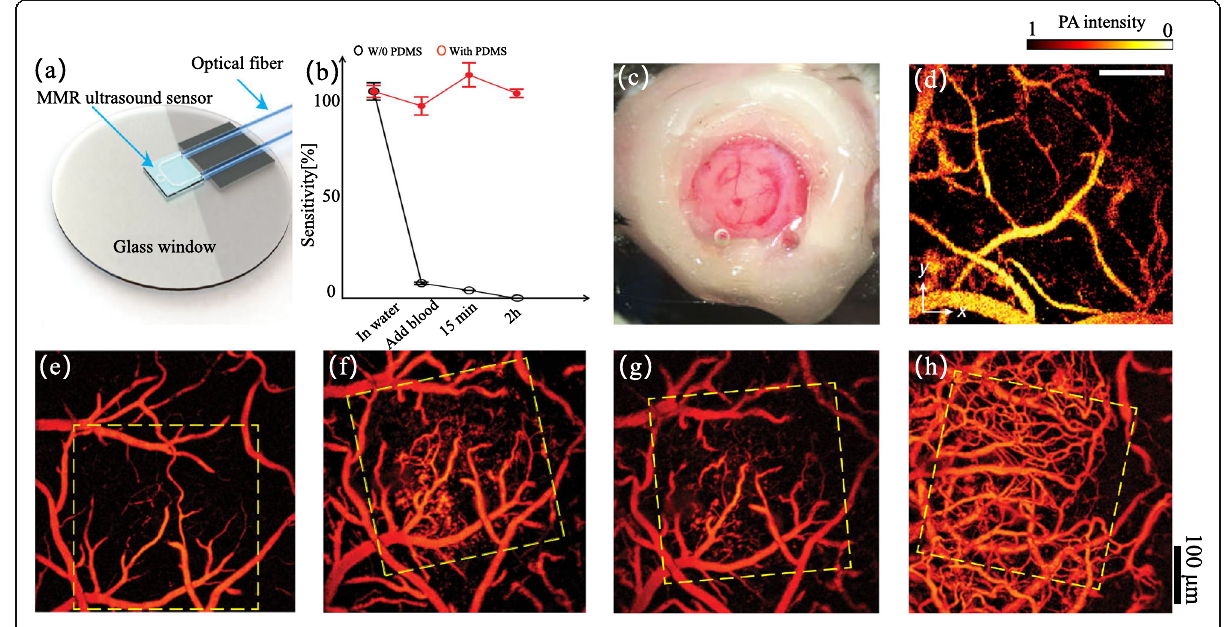
Fig. 5 a A schematic diagram of the ultrasound-sensing cranial window implant [42]. b Comparison of MRR Q-factors with and without the protection layer in whole blood. c A photograph of a fabricated chronic cranial window in mice. d A typical PA image of cortical vasculature in mice. e - h PA images of the cortical vasculature in the same area over a period of 28